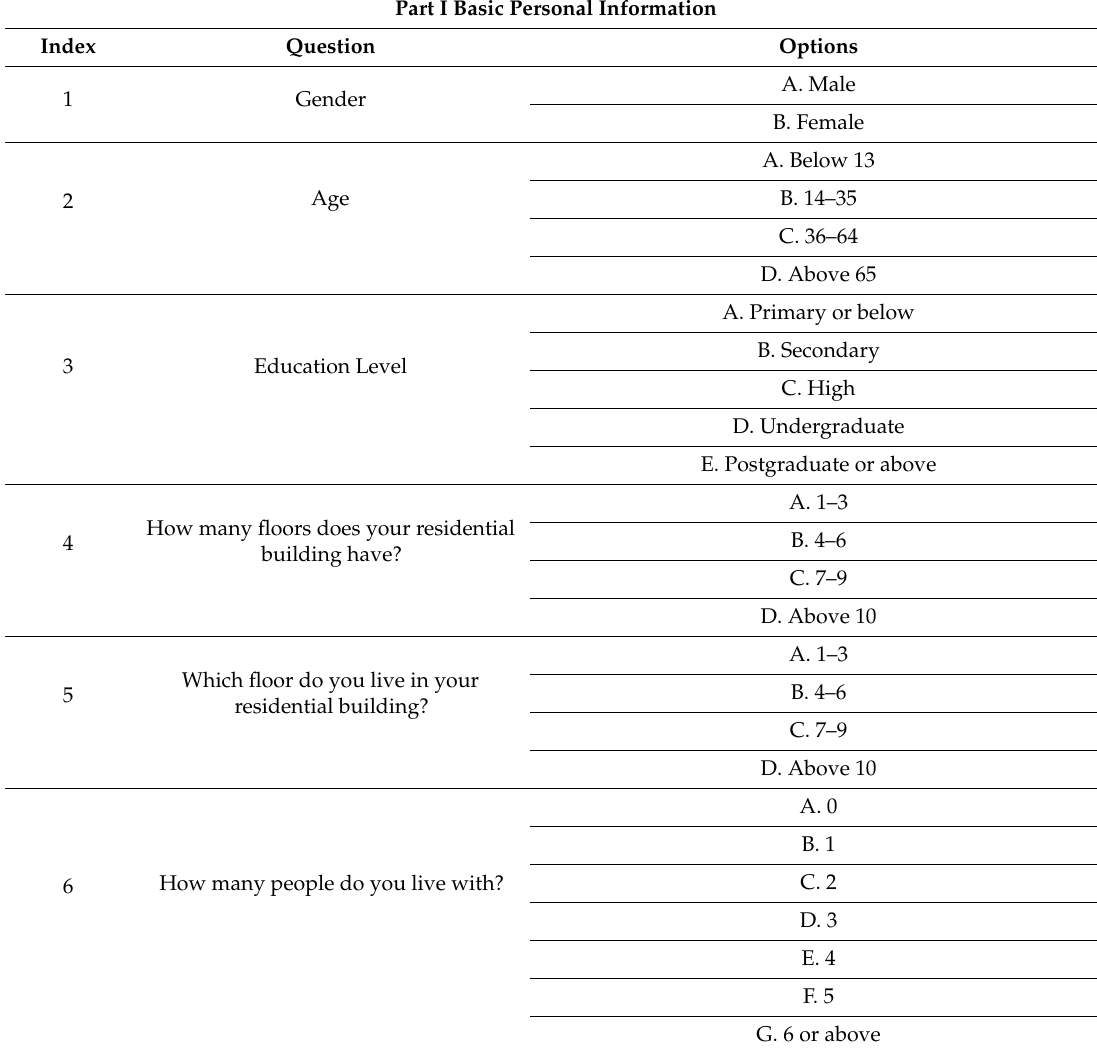
Table A1. Questionnaire on pre-evacuation behavior of community residents in an